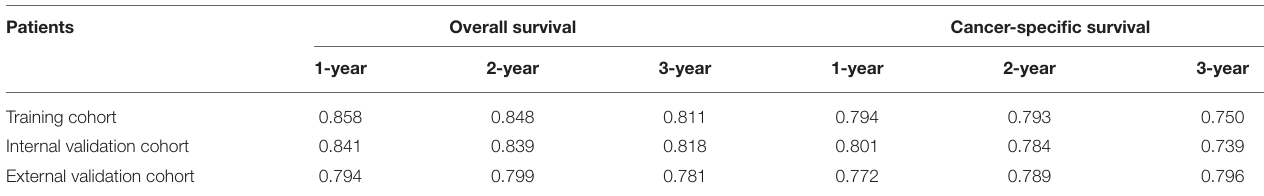
TABLE 3 | The AUC value of nomogram for predicting 1-, 2-, and 3-year OS and CSS.